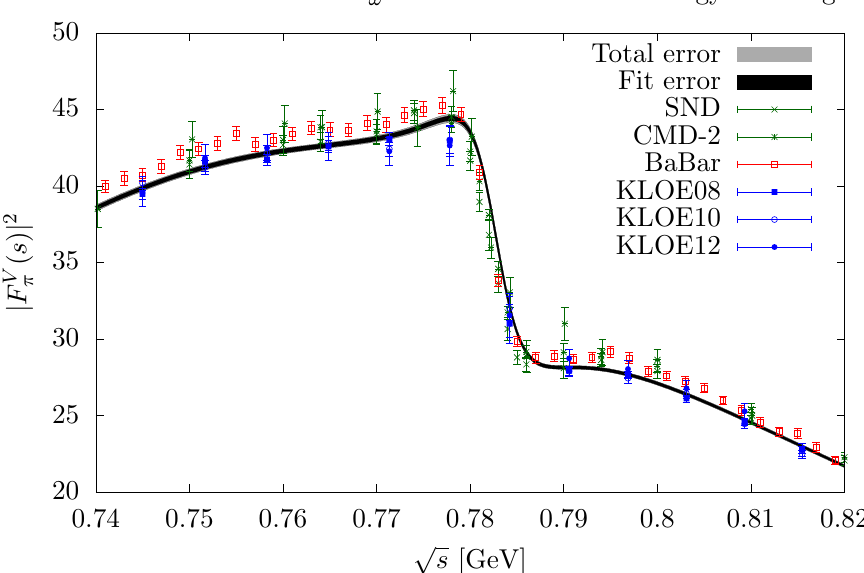
Figure 11. Fit result for the pion VFF in the (cid:26) { ! interference region, together with the e + e (cid:0) data sets. The curve is the result of the VFF (cid:12)t to the data points including energy rescaling as shown in (cid:12)gure 10, but with an ! mass reset to the PDG value and compared to the original data points without energy rescaling.